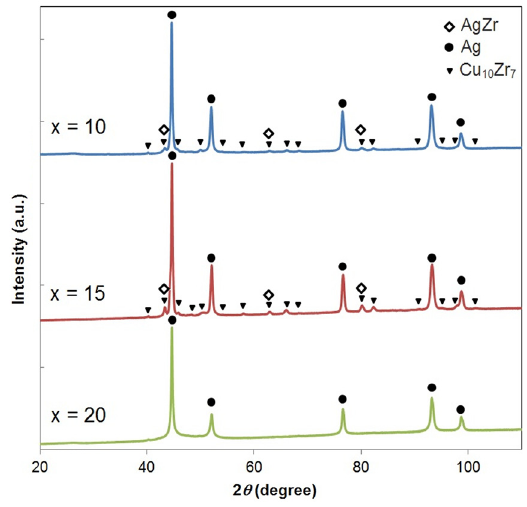
Cu Zr samples, 100-2x x x